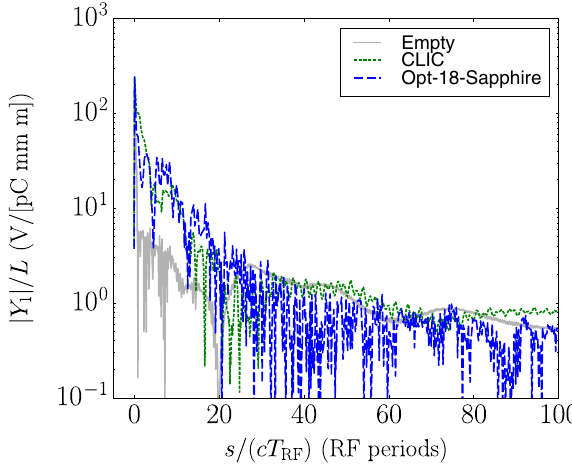
FIG. 14. Transverse dipole wake potentials in 8-cell cavities using conducting absorbers.